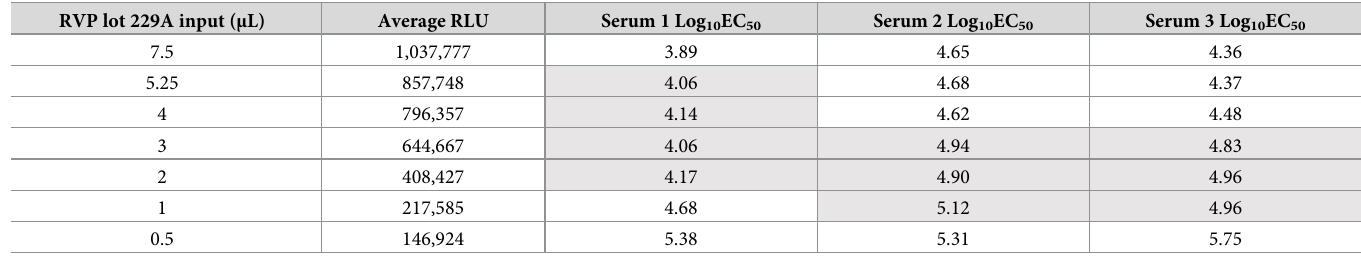
Determination of area of stable log EC titers for three sera positive for ZIKV neutralizing 10 50 antibodies using different input amounts of Z-RVP reagent (lot 229A). Z-RVP lot 229A input amounts of 2 μ L and 3 μ L resulted in similar log EC values within the variation of the assay 10 50 (0.2log10) for all three positive control sera. Signal stability, replication of measurements, and plate layout. The stability of the Renilla RLU signal in 384-well plates was assessed through an interleaved assay to determine uniformity and separation of signals to determine edge effect, drift or other spatial effects pres- ent in the assay as outlined in the Assay Guidance Manual by Eli Lilly & Company and the National Center for Advancing Translational Sciences [35]. The same operator carried out duplicate tests on two separate days (day 1, day 2) of maximum (max), mid, and minimum (min) RLU generating serum samples in different positions. The maximum RLU serum sam- ple was generated by diluting negative rabbit serum in assay media at a 1:1607.5 dilution. The mid RLU serum sample was generated by diluting ZIKV positive rabbit serum against ZIKV strain PRVABC59 in assay media at a 1:1607.5 dilution. The minimum RLU serum sample was generated by diluting the ZIKV positive rabbit serum against ZIKV strain PRVABC59 in assay media at a 1:5 dilution. For each max, medium and min RLU on the plate the mean RLU, standard deviation (SD) and Coefficient of Variation (CV) were determined. The % RLU midpoint as a surrogate EC50 between the three serum dilutions was calculated by the following equation: ( % RLU midpoint ¼ well ð mid Þ(cid:0) AVG ð min Þ � 100 ). AVG (min) was the average AVG ð max Þ(cid:0) AVG ð min Þ taken over the three minimum signal plate averages, and AVG (max) was the average taken over the three maximum signal plate averages [35]. The % RLU midpoint assessed the stability of the RLU midpoint while allowing for variation between max and min RLUs between plates. Acceptance criteria were based on the recommendations specific to high throughput screening assay validation in the Assay Guidance Manual by Eli Lilly & Company and the National Center for Advancing Translational Sciences [35]. The following acceptance criteria were established: CV (of the mean) � 20%, SD midpoint < 20%, RLU (signal) window � 2, Z’ factor � 0.4, drift or edge effects < 20%. Table 1. Titration of Z-RVP reagent for use in the Z-RVP-384